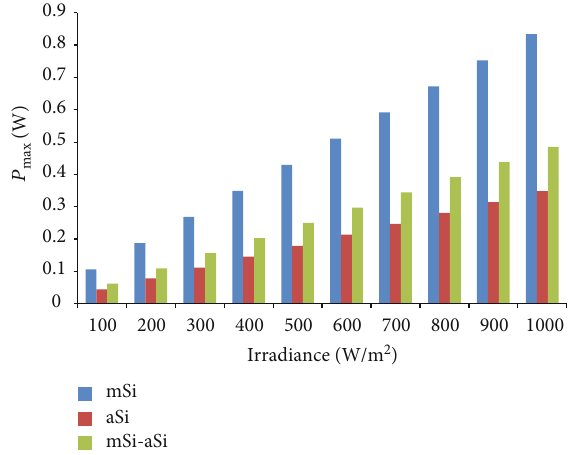
Figure 4: The average maximum power vs. illumination